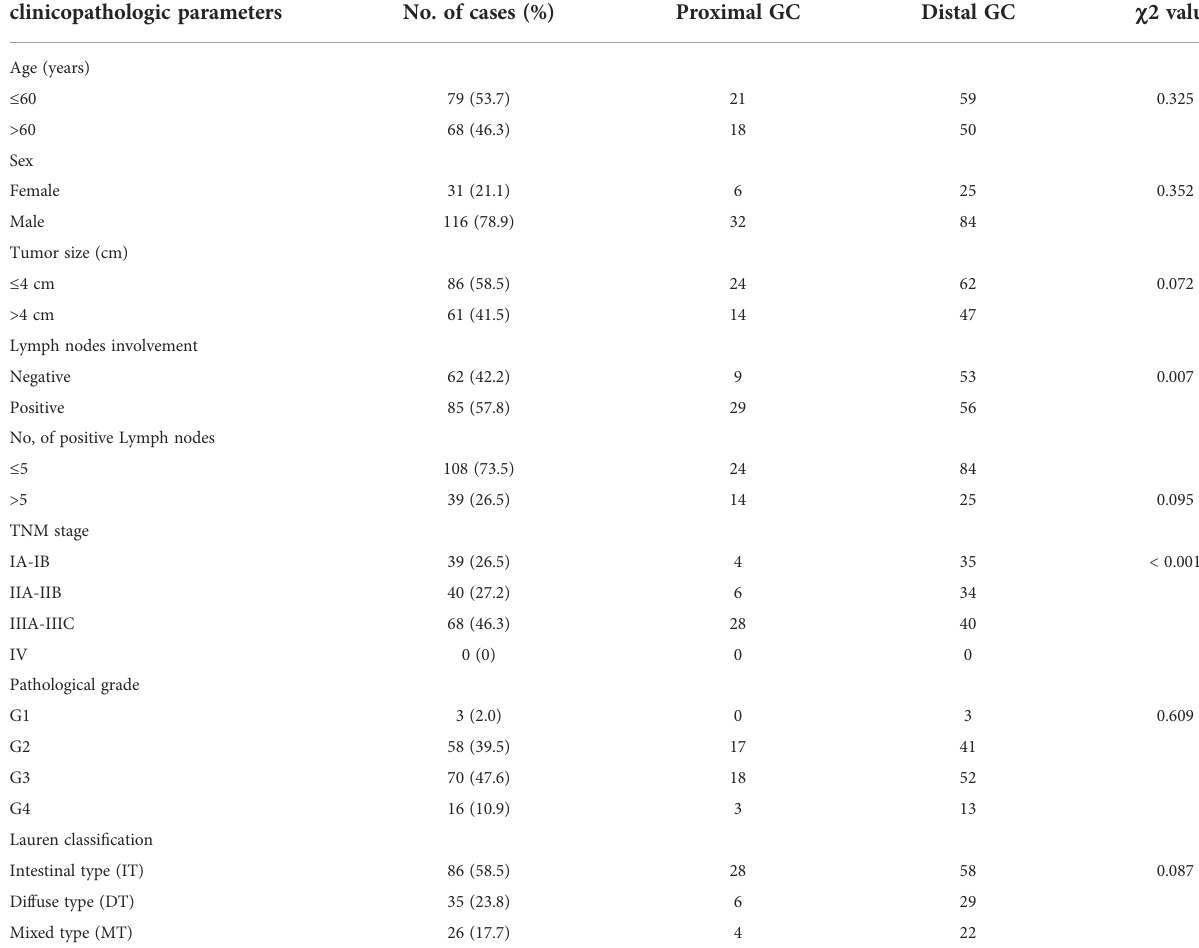
TABLE 2 Association of originating site of GC with clinicopathologic parameters. clinicopathologic